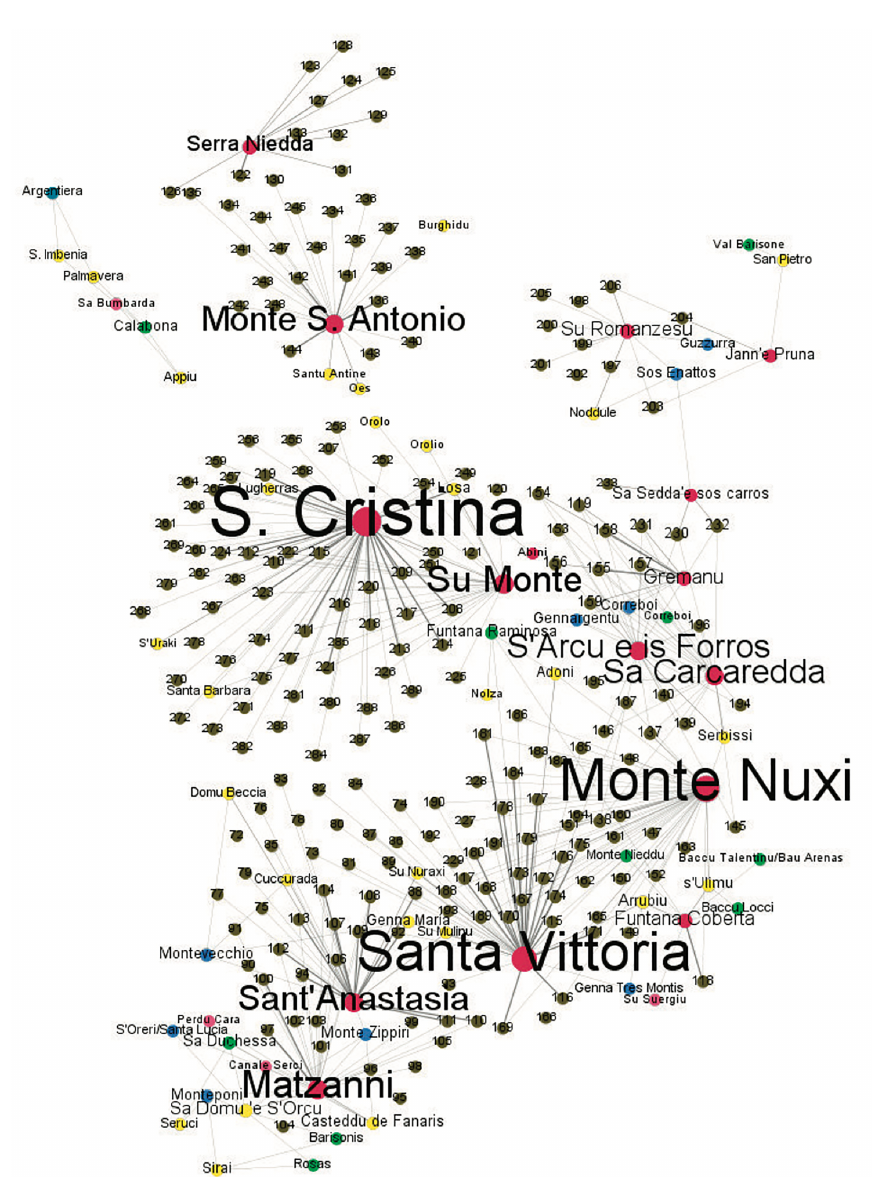
Figure 7. Network graph showing the connections between sanctuaries (in red), major settlements (yellow), other Nuragic settlements (brown), and ores (green, blue, pink) (from Matta 2020, p. 121, Figure